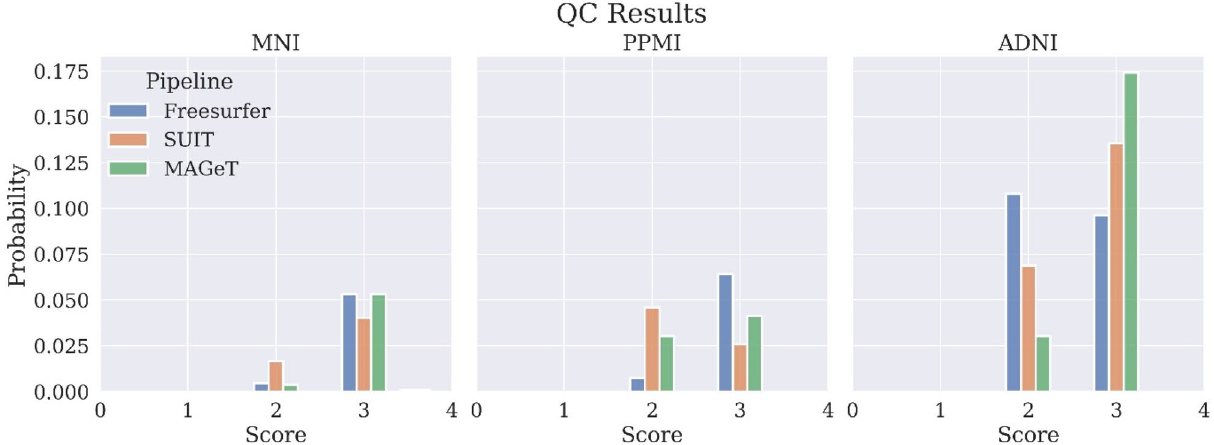
Figure 5. Quality assessment results for the augmented dataset including subjects from MNI, PPMI and ADNI datasets. Blue stands for Freesurfer cerebellar GM & WM segmentation results, orange for SUIT cerebellar lobular segmentation results and green for MAGeT cerebellar lobular segmentation results. Quality encoding: 1: exclude, 2: acceptable, 3: good, 4: excellent (only images with quality higher than 1 were included in this analysis and we did not find any results with quality 4 as